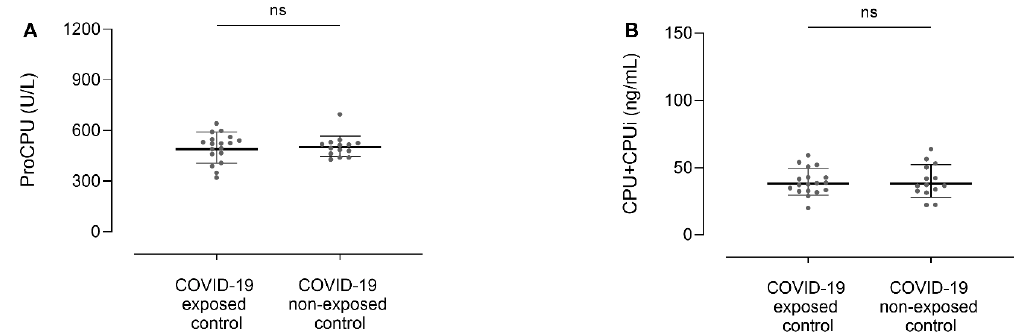
Figure 1. Plasma procarboxypeptidase U (proCPU) levels ( A ) and total active and inactivated car- boxypeptidase U (CPU+CPUi) antigen levels ( B ) in COVID-19 exposed (N = 14) and COVID-19 non- exposed (N = 18) controls. COVID-19 exposed controls are individuals that previously tested posi- tive for SARS-CoV-2 (PCR-confirmed SARS-CoV-2 infection (at least 2 months before inclusion) or a positive serological test result), while COVID-19 non-exposed controls are individuals without any evidence of SARS-CoV-2 exposure. Data are presented as mean ± SD. Mann–Whitney U test; ns = not significant.